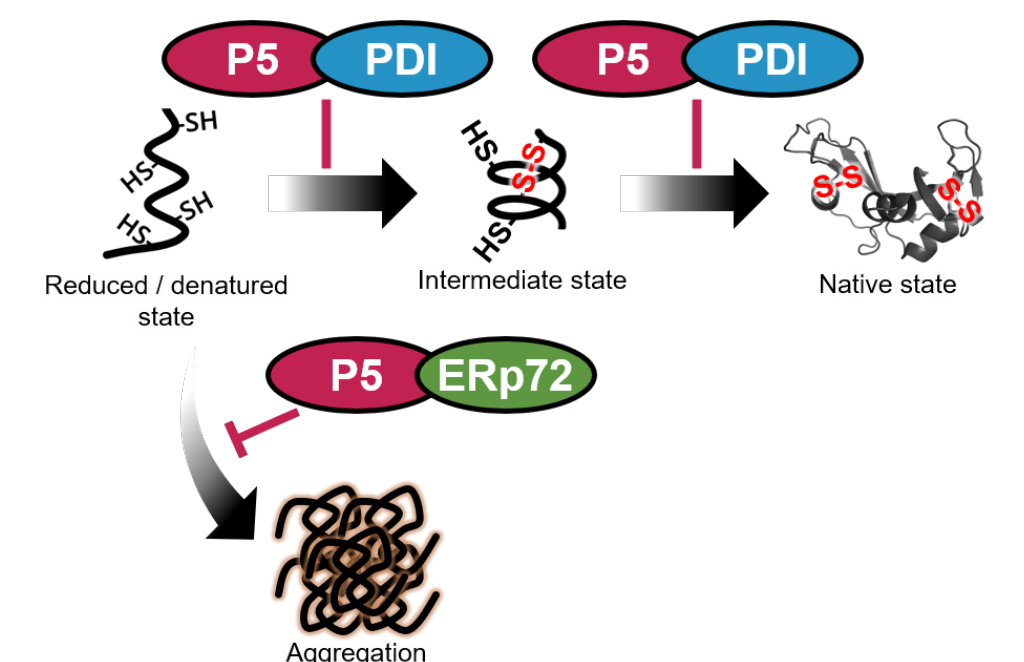
Figure 5. Schematic representation of the efficient productive folding system resulting from non-covalent interaction between P5, PDI, and ERp72. The combination of P5 and PDI enhances the efficiency of disulfide bond formation and isomerization during the oxidative folding reaction. Meanwhile, the combination of P5 and ERp72 efficiently inhibits aggregation of reduced and denatured substrates in the initial folding step. Straight and curved arrows indicate the progression of disulfide bond formation and isomerization during the oxidative folding reaction and the progression of misfolding and aggregation of unfolded substrates, respectively.